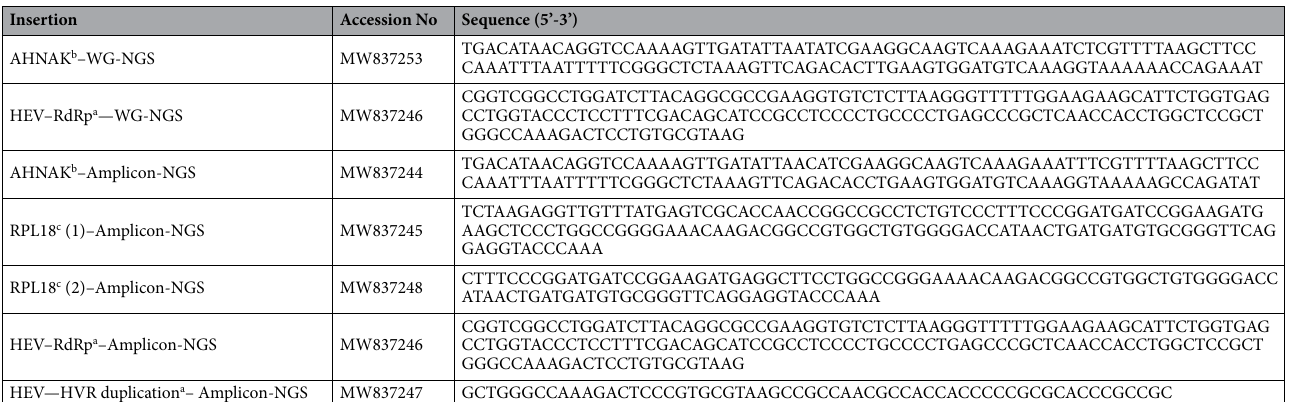
Table 2. HVR insertions. a Using wbGER27 as reference (accession No: FJ705359.1); b homo sapiens AHNAK nucleoprotein (human neuroblast differentiation-associated protein (desmoyokin), accession No.: NG_051822.1); c homo sapiens ribosomal protein L18 (RPL18, accession No.: L11566.1); HVR = hypervariable region; NGS = next generation sequencing; WG-NGS = whole genome next generation